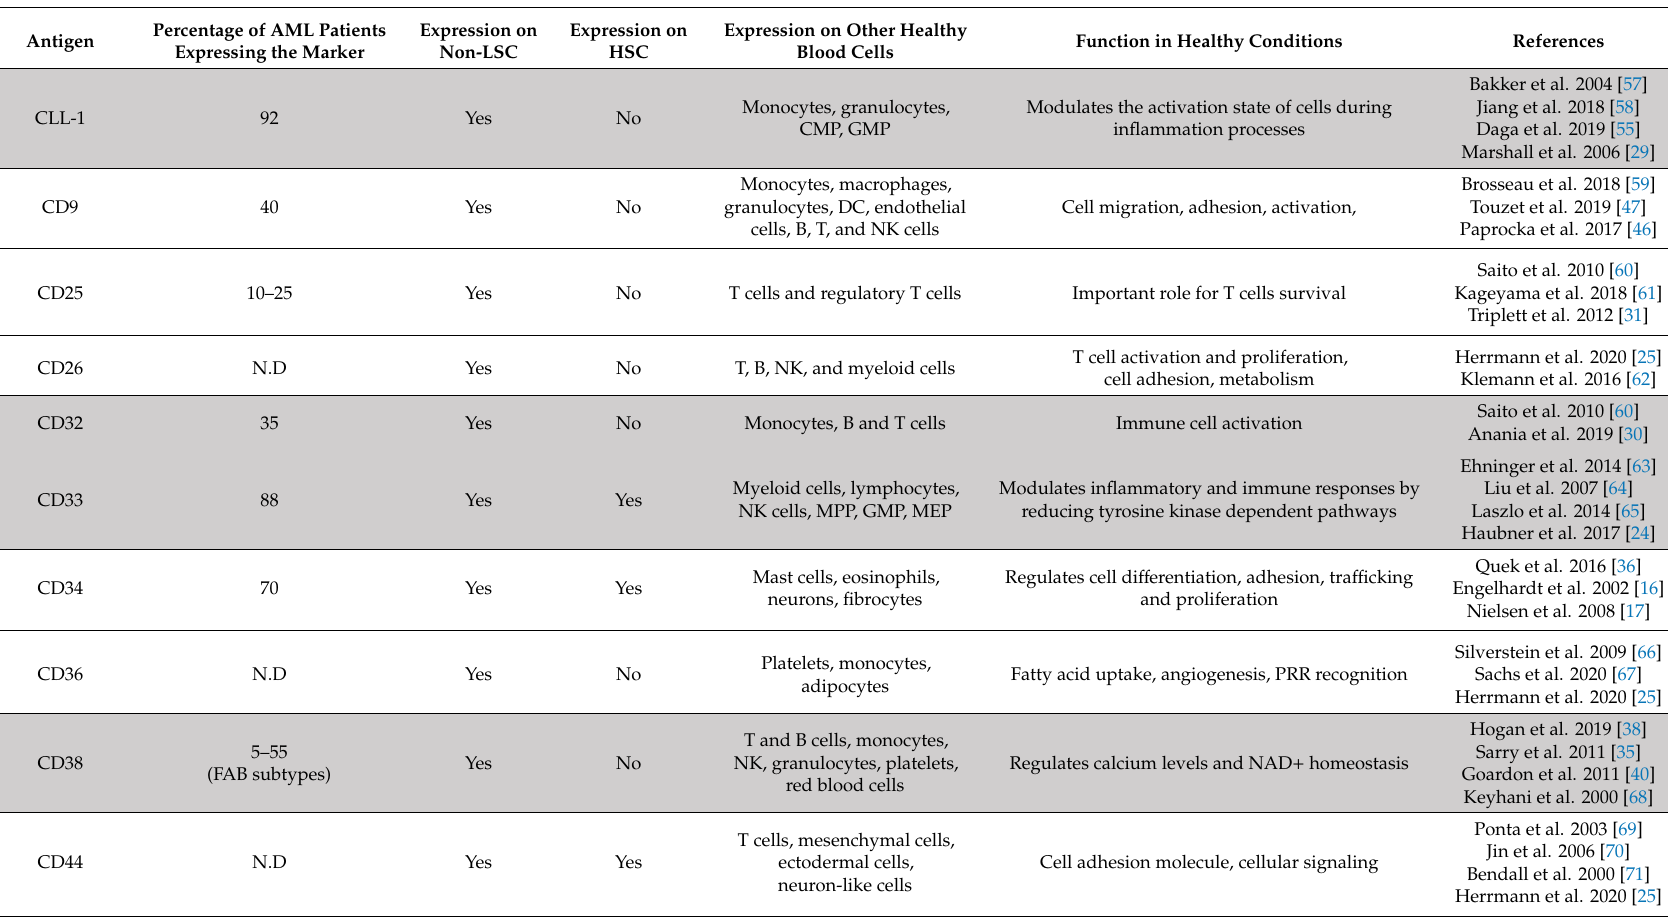
Table 1. Non-comprehensive list of human markers that can be found on LSC and their (potential) expression on the cell surface of other healthy blood cells. Highlighted in grey are the markers expressed on the cell surface of LSC from both CD34-expressing and non-expressing acute myeloid leukemia (AML). In white: markers only demonstrated to play roles in LSC from CD34 expressing AML. N.D: Not described / MPP: multipotential progenitor / MEP: megakaryocyte– erythroid